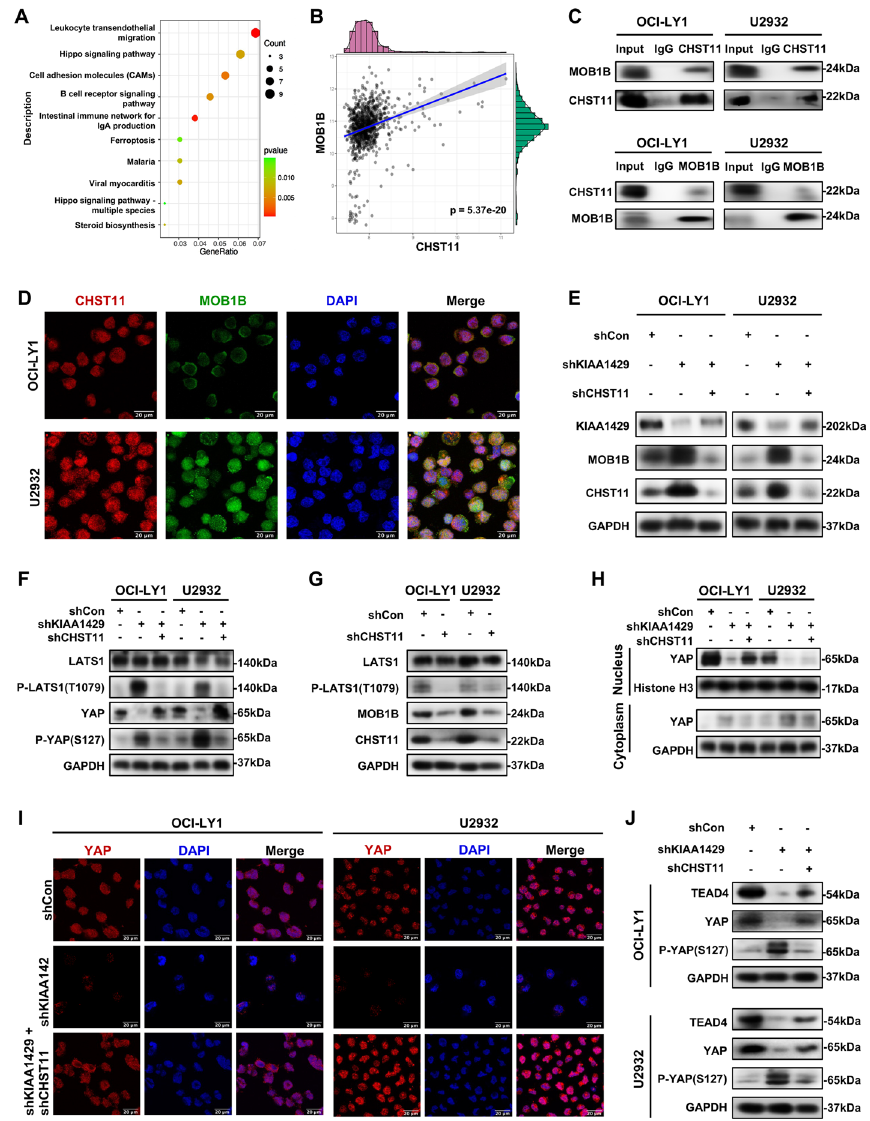
Fig. 7 KIAA1429 inactivated Hippo–YAP signaling by interacting with CHST11. A GO enrichment analysis showed high enrichment of the Hippo signaling pathway based on RNA-seq. B A positive correlation between CHST11 and MOB1B was found in Pearson correlation analysis. C The binding between CHST11 and MOB1B proteins was confirmed by co-IP in OCI-LY1 and U2932 cells. D Colocalization of CHST11 and MOB1B protein in OCI-LY1 and U2932 cells was exhibited in confocal immunofluorescent images. Bar, 20 μm. E The protein level of MOB1B was detected in DLBCL cells with or without KIAA1429 knockdown or with combined KIAA1429 knockdown and CHST11 knockdown. F Expression of core proteins in the Hippo pathway was examined in DLBCL cells with or without KIAA1429 knockdown or with combined KIAA1429 knockdown and CHST11 knockdown. G Knockdown of CHST11 suppressed MOB1B protein expression and LATS1 phosphorylation. H YAP expression was detected by western blotting after isolation and extraction of cytoplasmic and nuclear proteins. I Endogenous expression and subcellular localization of YAP were assessed by immunofluorescence staining. Bar 20 μm. Data were obtained from three independent experiments. J = Western blotting showed that knockdown of CHST11 rescued the KIAA1429 knockdown-induced decrease in YAP and TEAD4 expression and increase in YAP